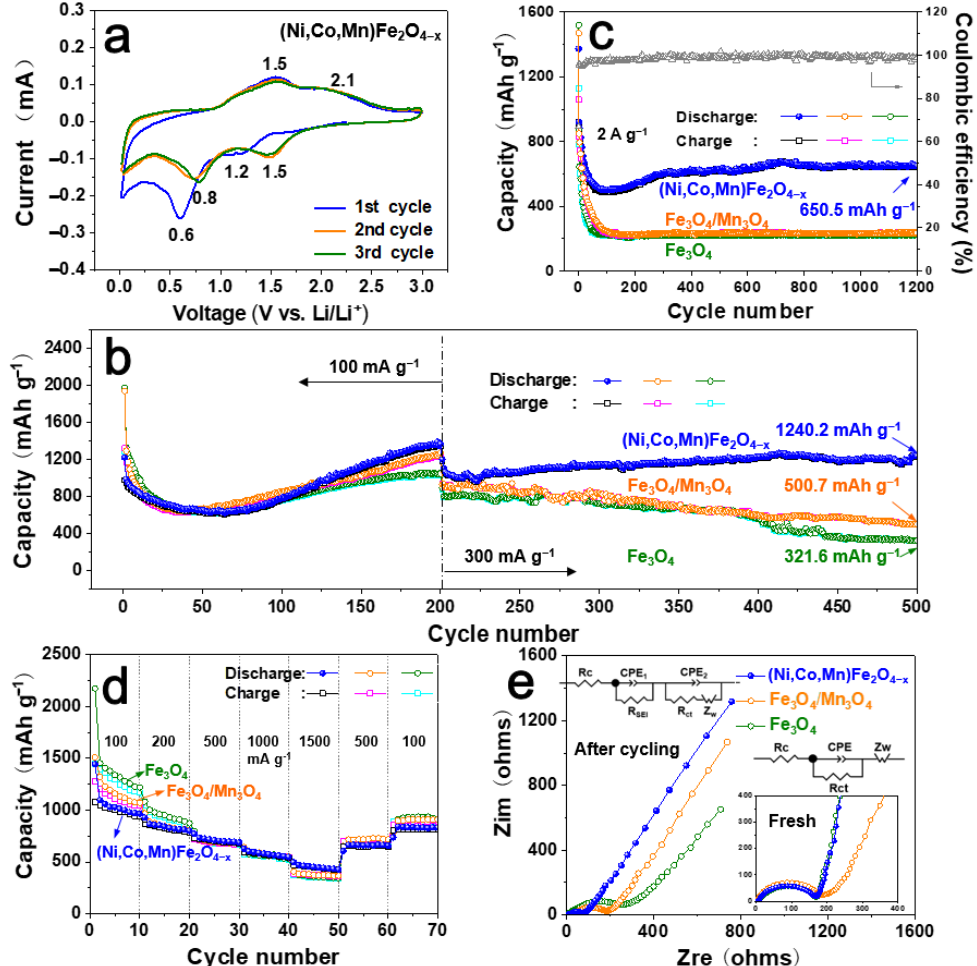
Figure 5. Electrochemical performance of the as-prepared (Ni,Co,Mn)Fe 2 O 4 − x . ( a ) Cyclic voltamme- try tested at 0.01–3 V at a scan rate of 0.1 mV/s. ( b , c ) Long cycle performance at different current densities: ( b ) 100 mA g − 1 for 200 cycles and 300 mAg − 1 for the following 300 cycles and ( c ) 2 Ag − 1 for 1200 cycles. ( d ) Rate performance at varied current densities ranging 100–1500 mA g − 1 . ( e ) Nyquist plots of fresh cells (inset) and cells after cycling.